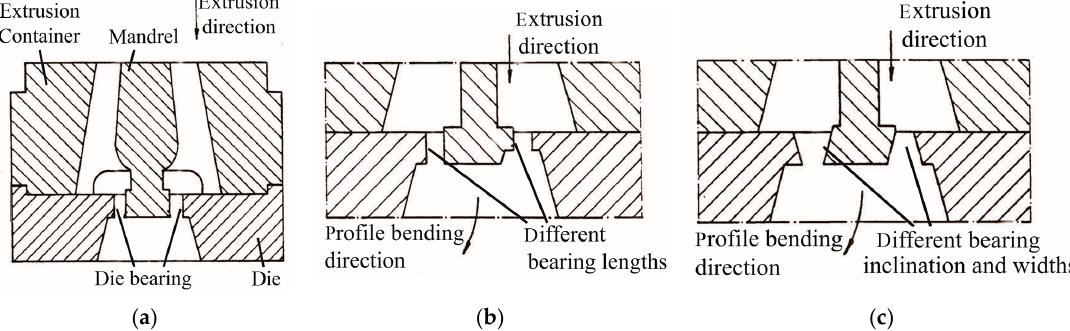
Figure 23. Design of the extrusion die bearing geometry to achieve curved profiles: ( a ) initial equal die bearing, ( b ) different die bearing lengths, ( c ) different inclination angles and gap widths of the die bearing [90].